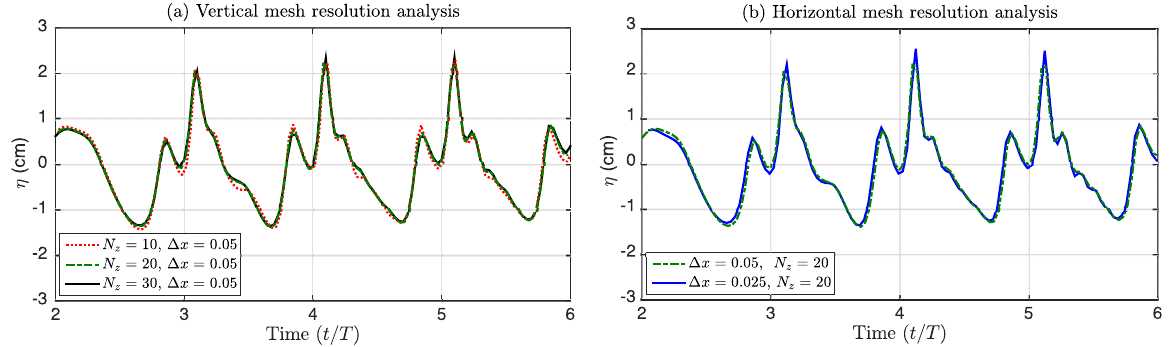
Figure 7. Grid convergence study of the wave profile at x = 6.68 for Test